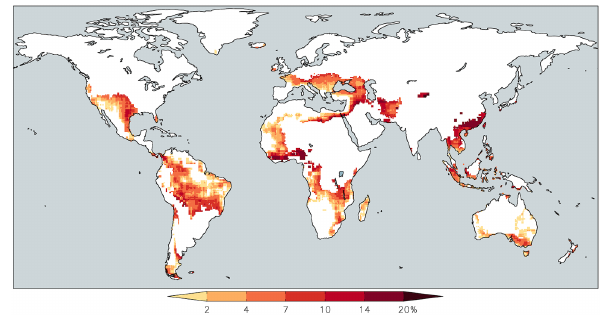
Figure 5. Change from the historical to the RCP8.5 case in the aver- age IASD of monthly mean precipitation shown only for locations where it is positive but the change in annual mean precipitation is